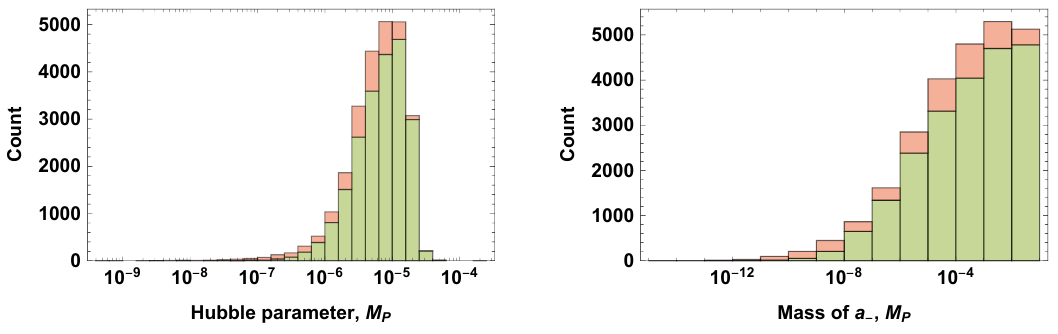
Figure 5 . Left panel: a histogram of the values of Hubble parameter at horizon exit for the same data set as in (cid:12)gure 1 for points that are consistent (green) and not consistent (red) with experimental constraints on r and n s . Right panel: the same as the left panel except the histogram of the in(cid:13)aton a (cid:0) mass is shown